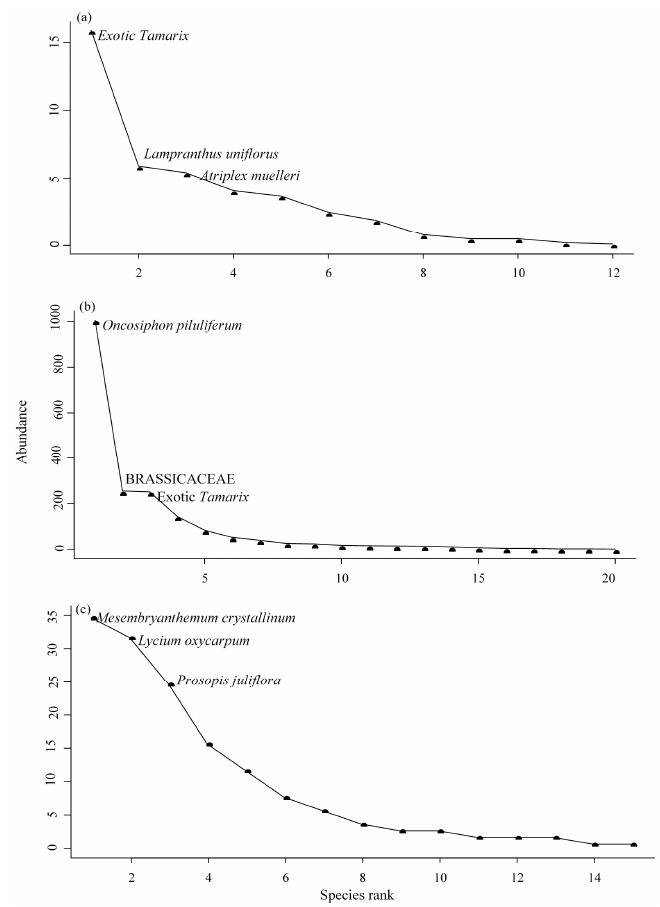
Figure 5. Rank abundance curves showing the top three most abundant species for ( a ) Swart, ( b ) Olifants, and ( c ) Leeu rivers, Western Cape, South Africa. The curves are all steep, and exotic Tamarix only occurs in the top three most abundant species along the Swart and Olifants rivers.